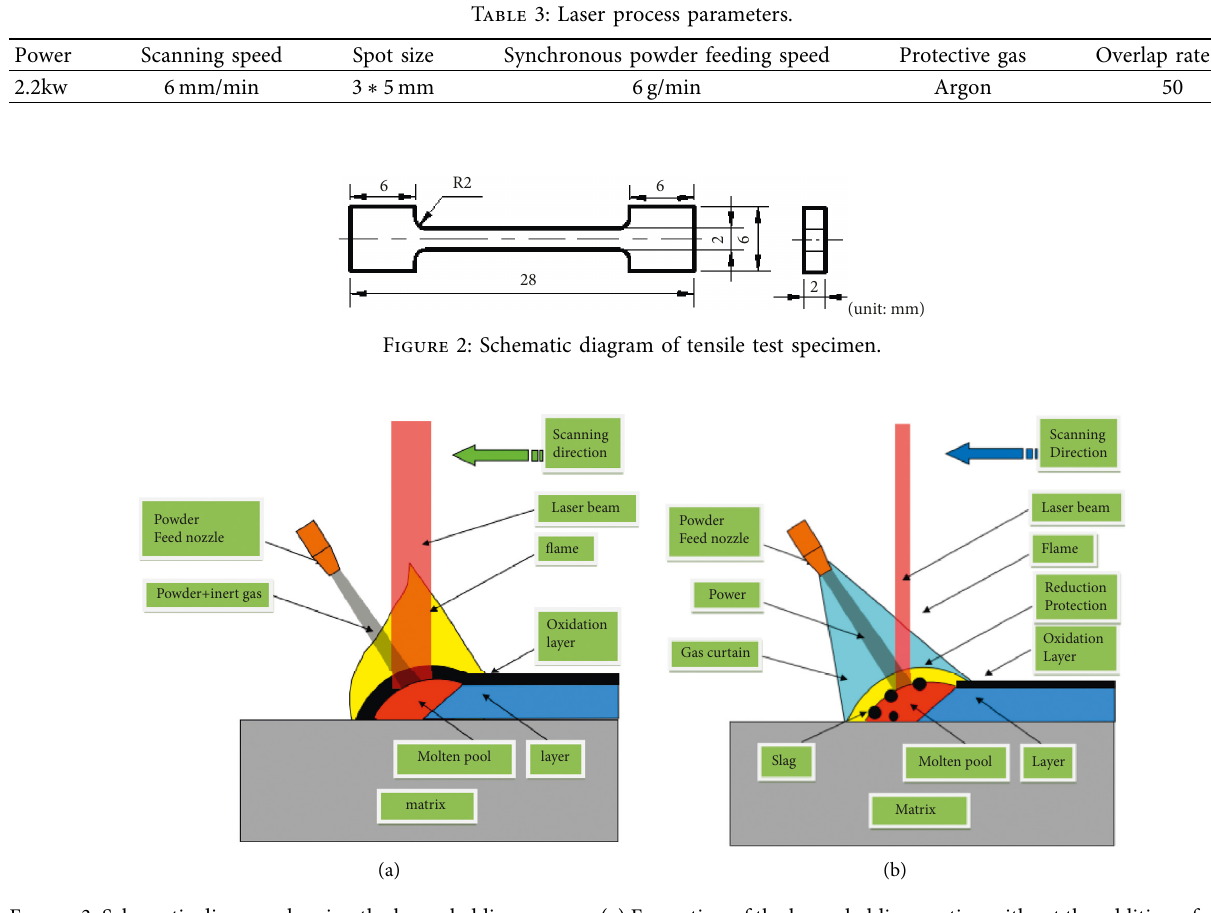
Figure 3: Schematic diagram showing the laser cladding process. (a) Formation of the laser cladding coating without the addition of rosin. (b) Formation of the laser cladding coating after addition of rosin under outer ring protective gas curtain.